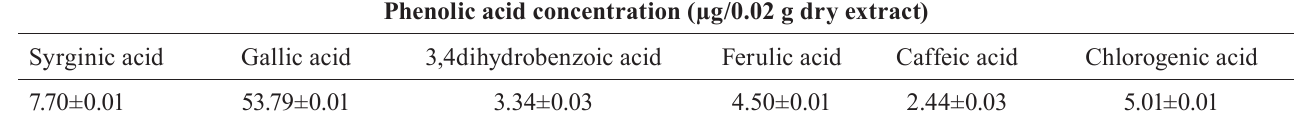
TABLE I - P henolic acid and flavonoid compounds of R. ribes